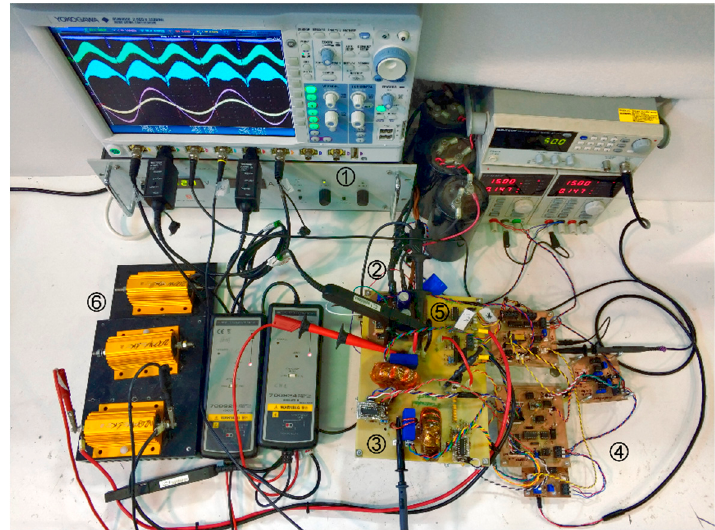
Figure 24. Experimental setup and microinverter prototype.